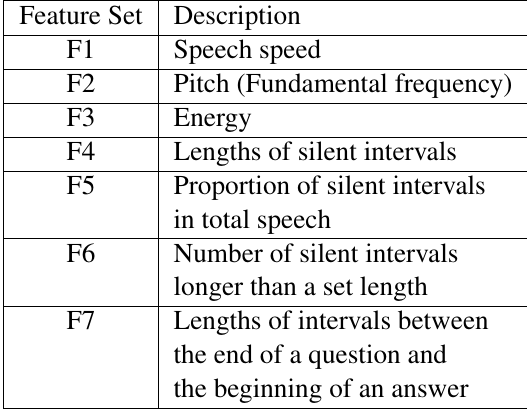
Table 2. Description of input variables.(Source: findings from the preliminary experiments for this